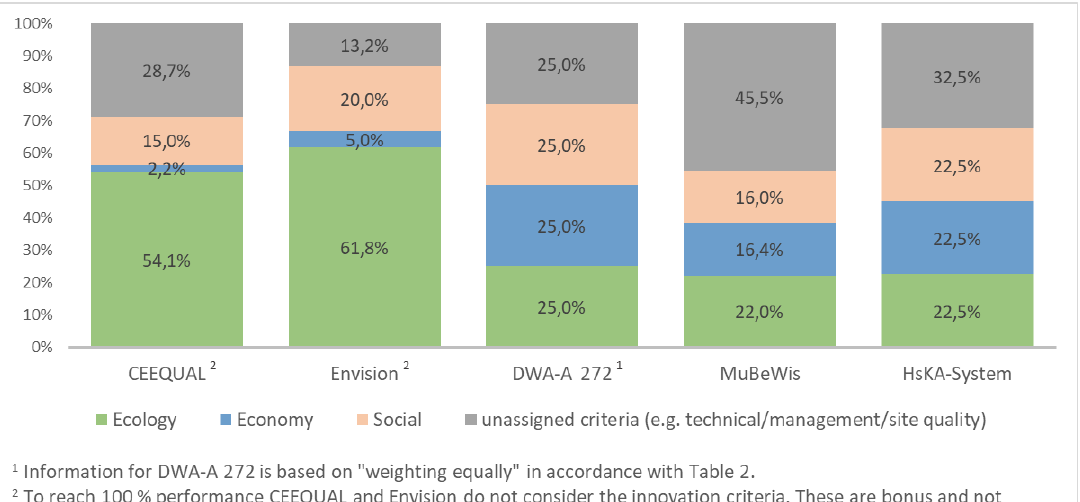
Figure 4. Weighting of the three sustainability dimensions in selected schemes.